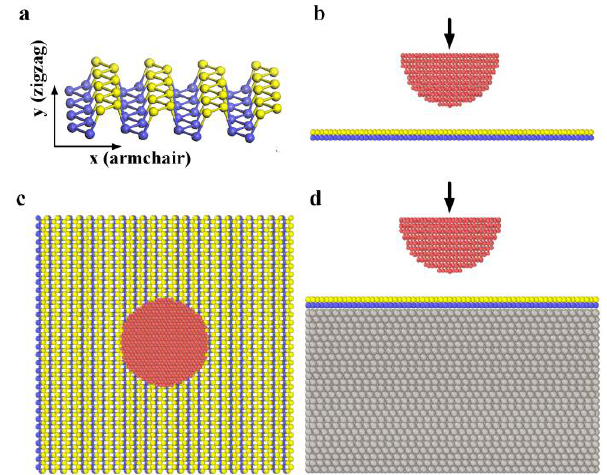
Figure 1. ( a ) Atomic structure of the black phosphorus (BP) monolayer. P atoms at the top layer are shown in yellow while P atoms at the bottom layer are shown in blue; ( b , c ) Left and top view of the simulation model for the indentation process of a freestanding BP monolayer; ( d ) Left view of the simulation model for the indentation process of a Pt(111)-supported BP monolayer.